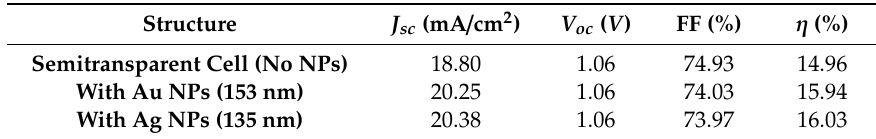
Figure 8. J–V curves of the semitransparent solar cell and the cell with the added Ag and Au NPs at optimized diameters. Table 3. Comparison of the electric parameters of the semitransparent cell with no NPs and with Au and Ag NPs.